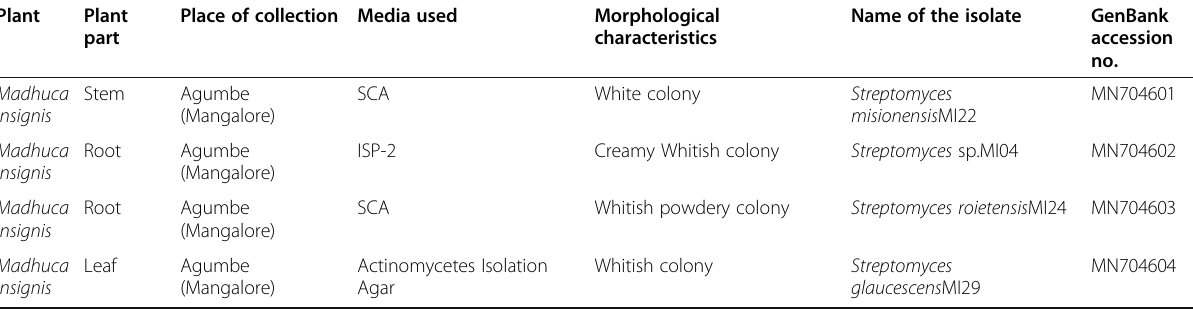
Table 1 List of endophytic actinomycetes strains isolated from Madhuca insignis with their morphological features and GenBank